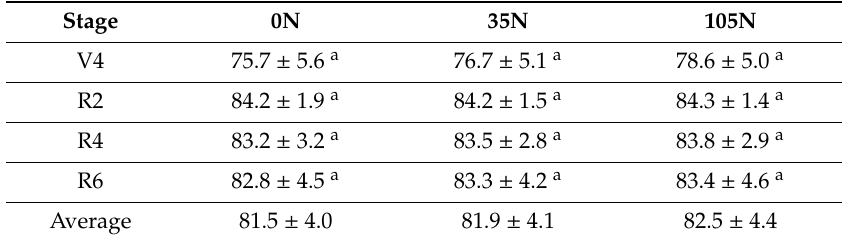
Table 5. The e ff ect of di ff erent fertilization rates on NDVI at di ff erent stages of soybean’s (cv. Pannonia Kincse) life cycle, averaged among 2017, 2018, and 2019 in Debrecen,